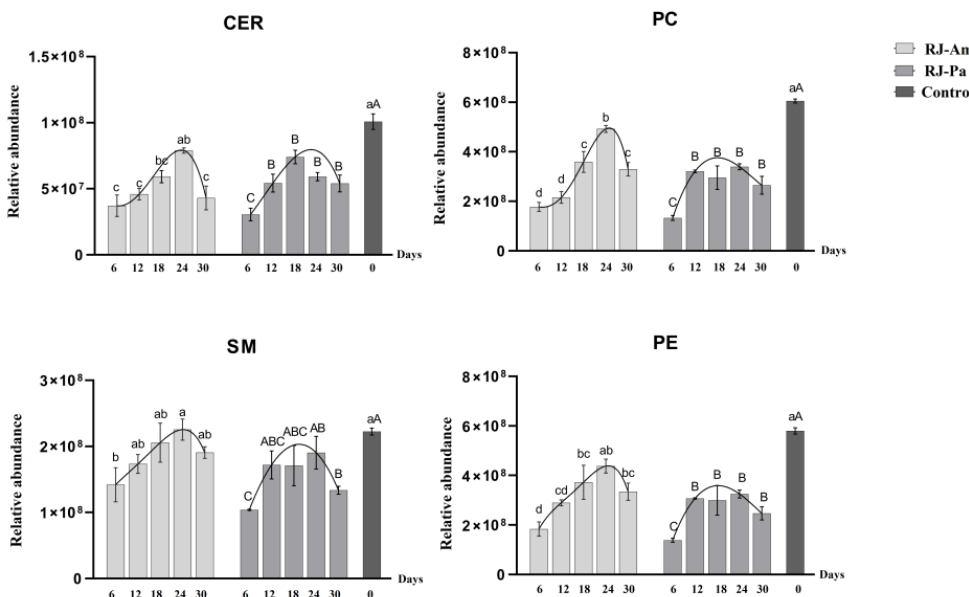
Figure 1. Changes in levels of phosphatidylcholines (PCs), phosphatidylethanolamines (PEs), ceramides (Cers), and sphingomyelins (SMs) in royal jelly secreted by honeybees fed bee pollen from a single plant source, Acer mono Maxim. (BP-Am) or Phellodendron amurense Rupr (BP-Pa). Samples were collected on days 6, 12, 18, 24, and 30 after honeybees began feeding on single bee pollen. RJ-Am, royal jelly secreted by honeybees fed BP-Am; RJ-Pa, royal jelly secreted by honeybees fed BP-Pa. Significant differences in lipid content of RJ-Am or RJ-Pa secreted by honeybees fed BP-Am or BP-Pa at different timepoints are indicated with lowercase letters (a, b, c, d) and uppercase letters (A, B, C), respectively.